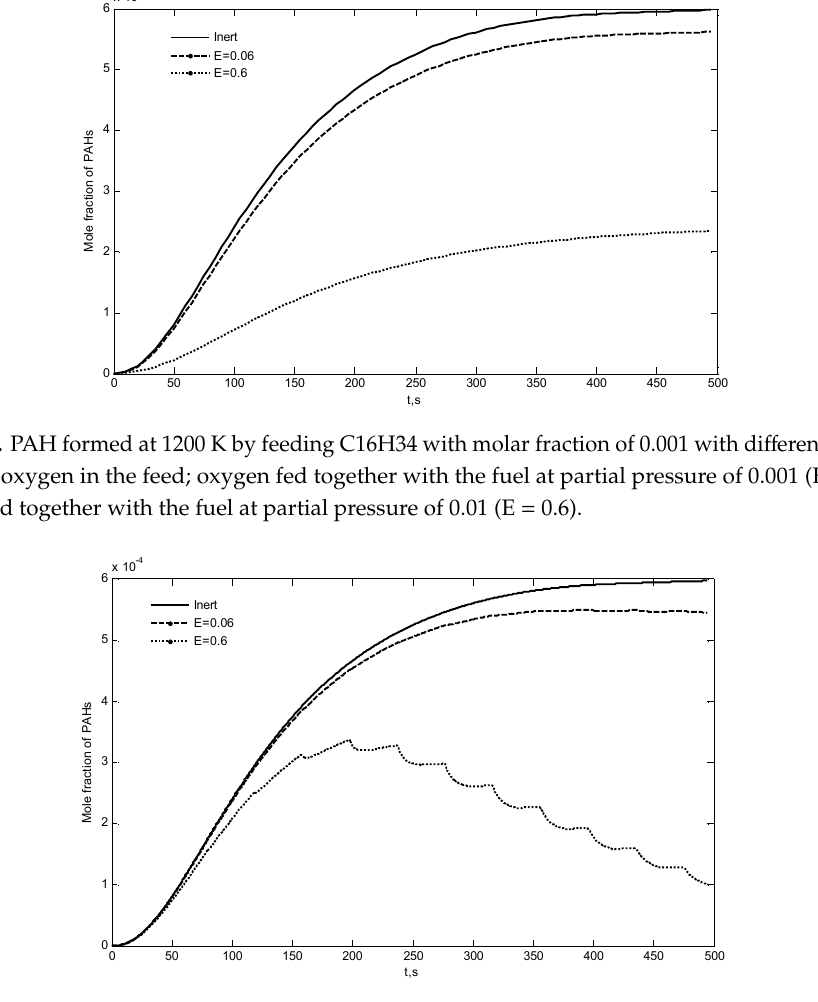
Figure 14. PAH formed at 1200 K by feeding C 16 H 34 with molar fraction of 0.001 with di ff erent oxygen feeds: no oxygen in the feed; oxygen fed in 13 steps for a cumulative value of E = 0.06; oxygen fed in 13 steps for a cumulative value of E =